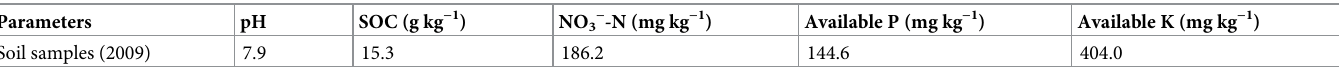
Table 1. Characteristics of the soil sampled in